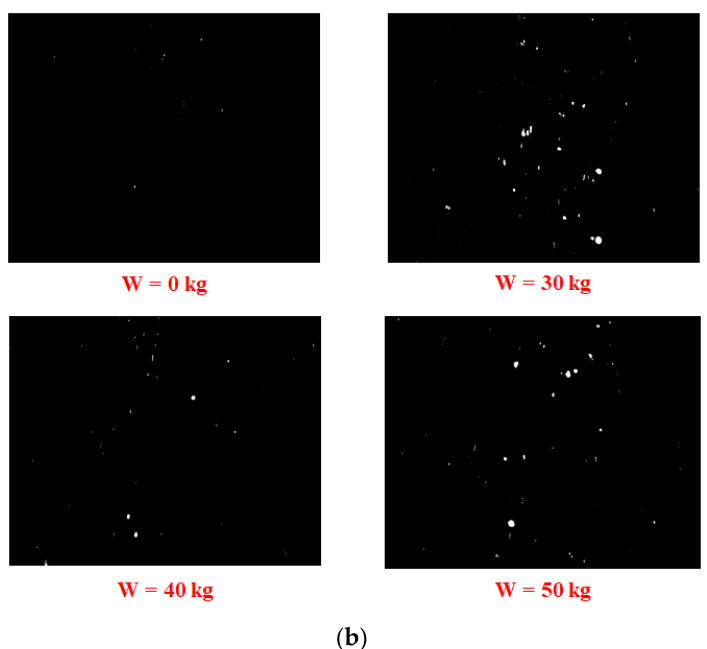
Figure 6. Representative images obtained at the location of ( a ) 1 and ( b ) 2 for different weights.